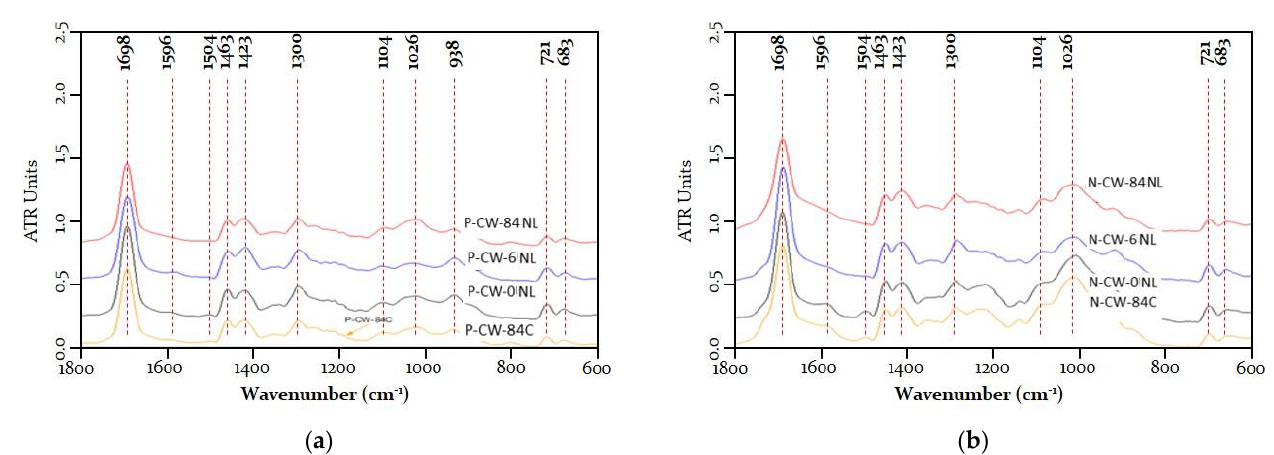
Figure 6. Comparative FTIR spectra (in the fingerprint region 2000 – 600 cm −1 ) of wood samples coated with Chinese wax (CW) before and after simulated natural ageing for 6 (6UV) and 84 months (exposed 84UV and covered areas 84C): ( a ). European Maple wood (P); ( b ). European Walnut wood (N).